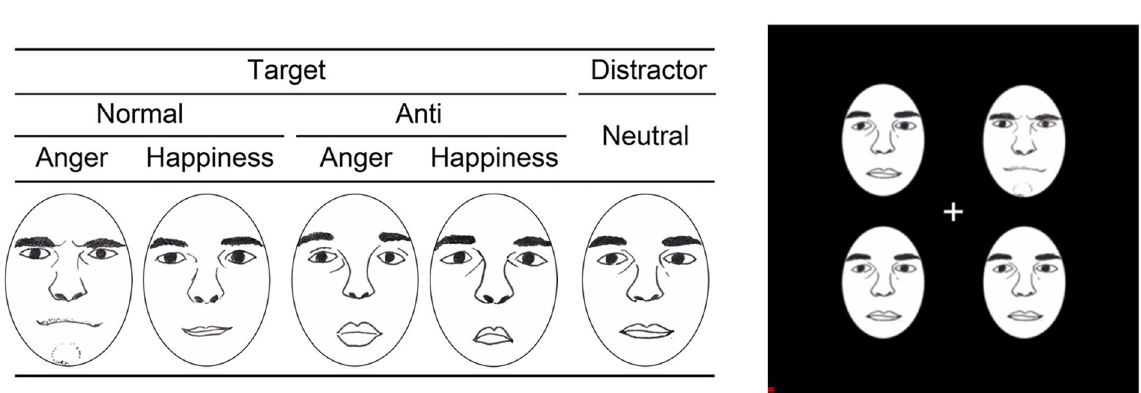
Figure 2. Illustrations of stimuli (left) and the visual search display (right). Actual stimuli were photographs of faces. Images in the figure are drawn by the author Prof. Wataru Sato.